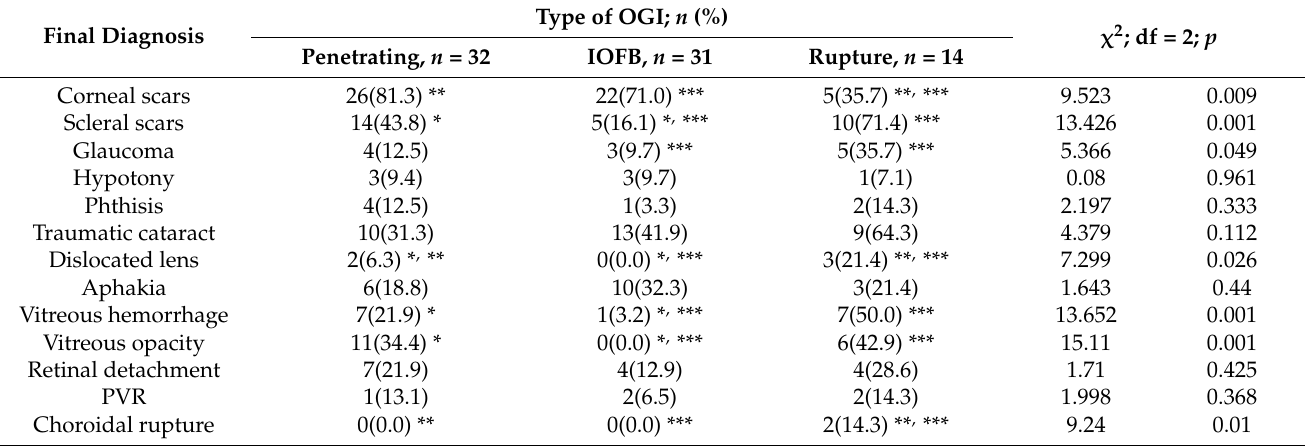
Table 7. Final diagnosis according to the type of open globe